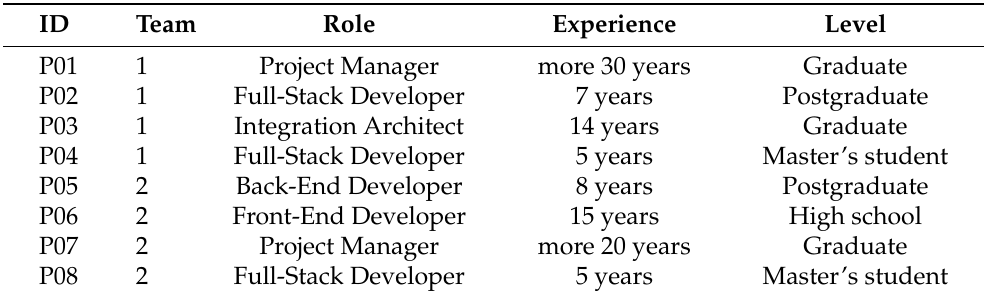
Table 2. Profile of the development